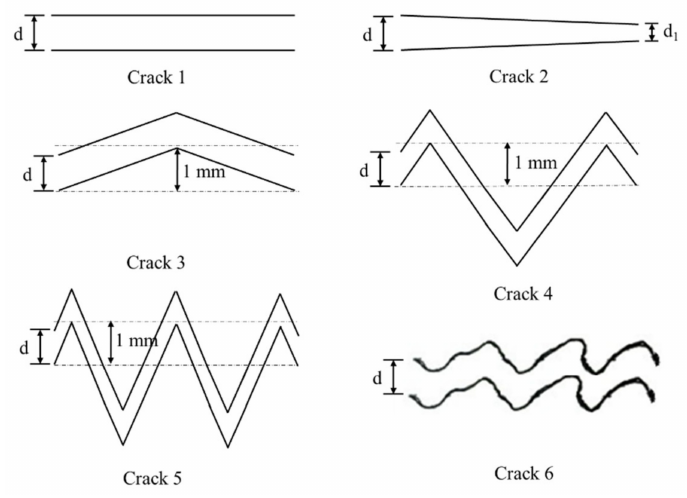
Figure 3. Crack geometries adopted in the